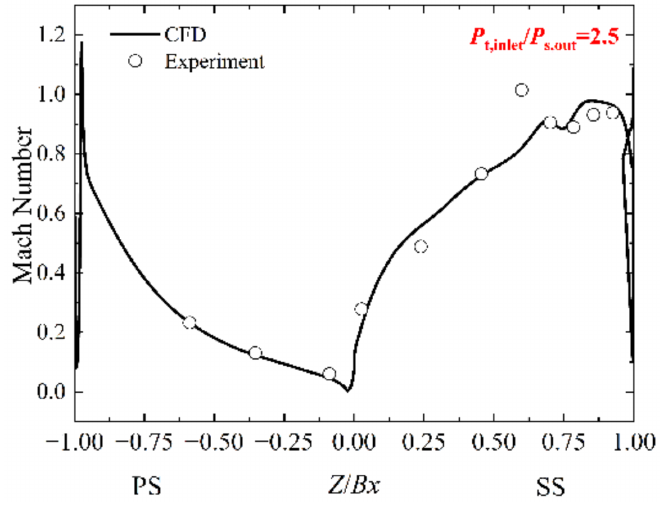
Figure 2. Mach number profiles at midspan under P t,inlet / P s,outlet =